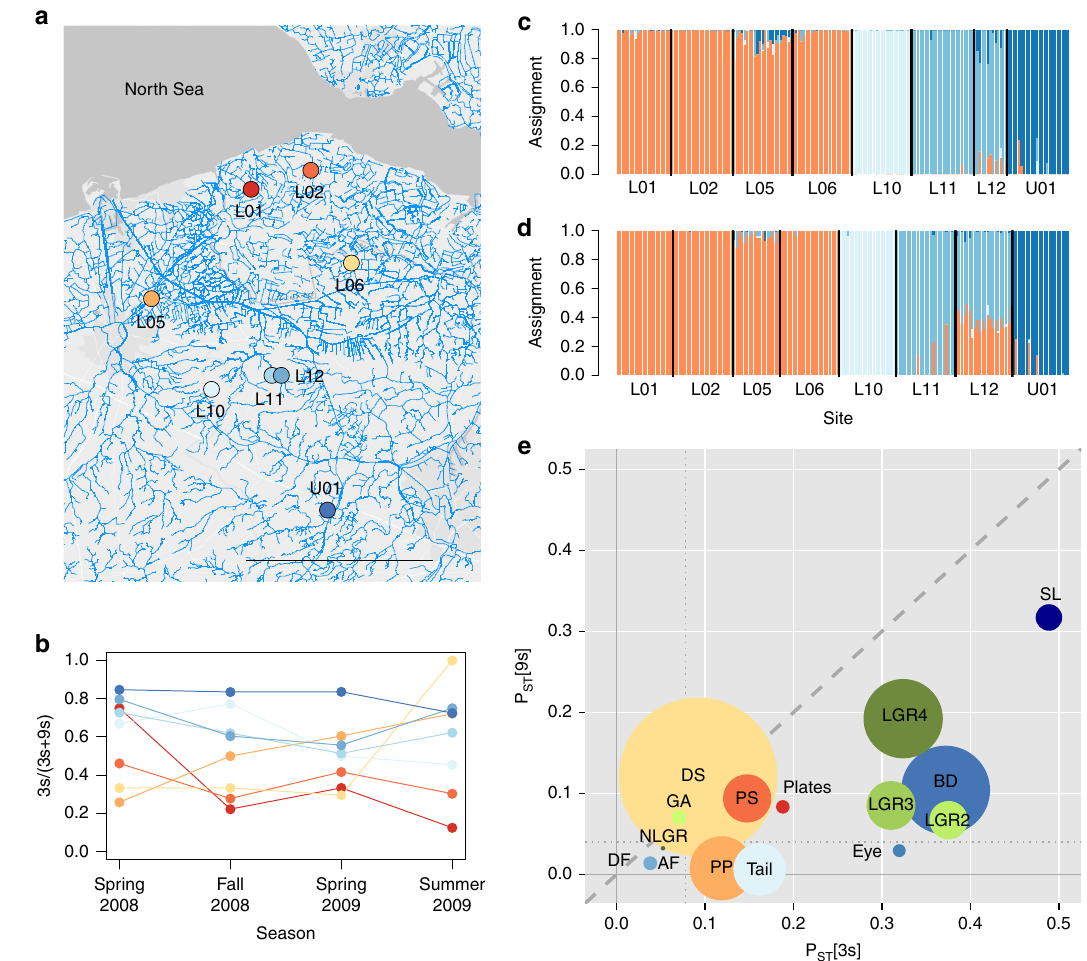
Fig. 1 Locations and characteristics of eight coexisting populations of the three-spined ( 3 s ) and nine-spined ( 9 s ) stickleback. a Map of the Belgian-Dutch lowlands with brackish and freshwater sites represented by orange-red and blue-shaded dots , respectively. Site characteristics and sample size are listed in Supplementary Table 1. The length of the scale bar is 20 km. b Population density of the 3s stickleback relative to the total density of 3s and 9s stickleback, over four consecutive seasons. Across the eight sites, this proportion increased with decreasing salinity (Spearman ρ = − 0.71; P = 0.0465). Sampling bias unlikely explains this result, because standard catches were done with a hand net at sites with little escape opportunity (see Supplementary Methods). c – d Bayesian analysis of neutral genetic structure among populations of the 3s stickleback c and 9s stickleback d , based on 12,684 and 10,068 neutral SNPs, respectively. We identi fi ed similar genetic clusters in both species, including a cluster corresponding to the brackish water populations ( orange ), and three clusters of freshwater populations corresponding to L10 ( light blue ), L11 and L12 ( blue ) and U01 ( dark blue ). e Phenotypic differentiation ( P ST ) in the 3s vs. the 9s stickleback for 15 morphological traits, including standard length ( SL ) (for codes of other traits, see Supplementary Table 2). Shades of red-orange , blue and green represent armour traits, body shape and gill morphology, respectively. The size of the circles is indicative for the importance of parallel vs. non-parallel effects, quanti fi ed as the ratio of the corresponding effect sizes (see Supplementary Table 2). The dashed line represents the 1:1 line, indicating that P ST [3s] generally exceeds P ST [9s]. The dotted lines mark the level of neutral genetic divergence (3s: F ST = 0.078; vertical line ; 9s: F ST = 0.040; horizontal line